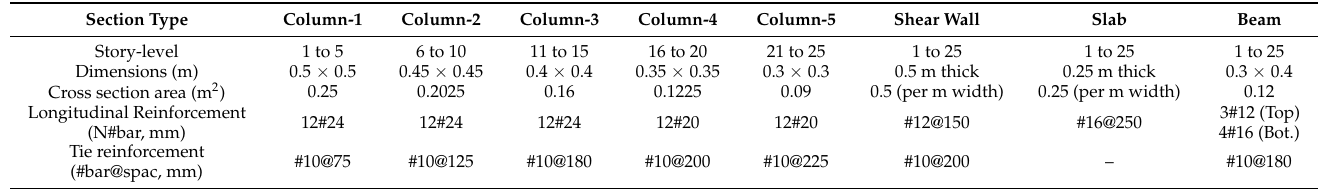
Table 1. Details of the designed sections used in the